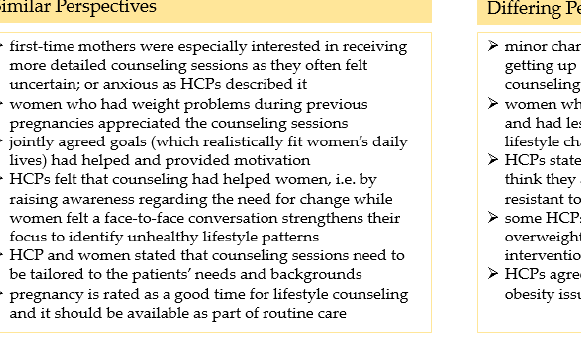
Figure 2. Summary of the results in Section 3.1.